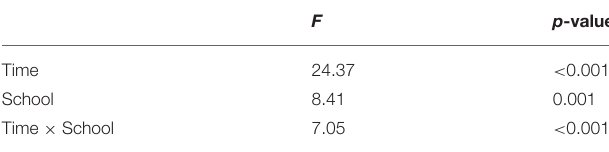
TABLE 3 | Results of repeated measures ANOVA ( n =